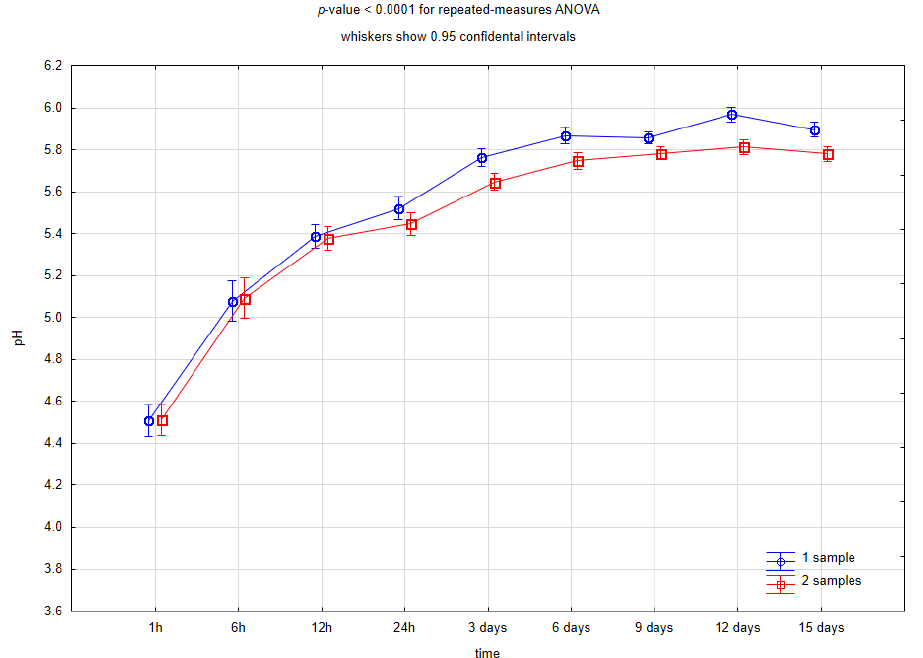
Figure 4. Repeated-measures analysis of variance for pH values in the individual time points depending on the number of the samples for Ketac Molar Easymix.